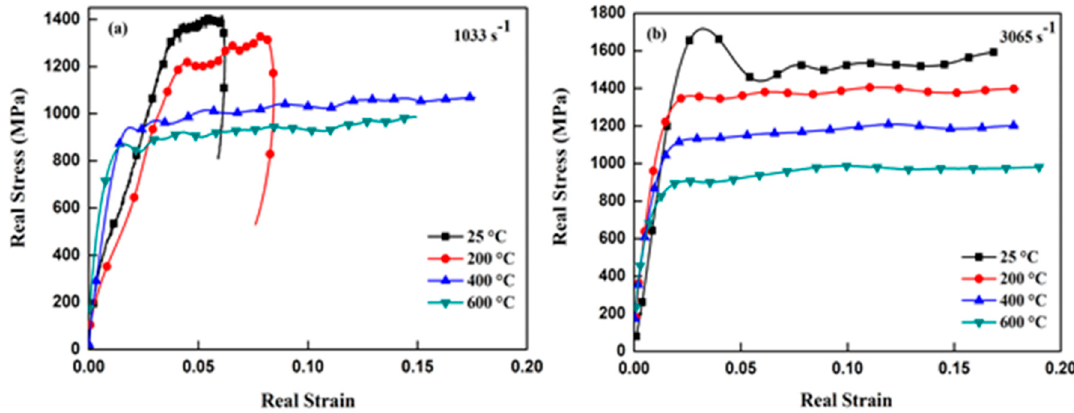
Figure 11. Stress–strain curve of TC18 alloy at the same strain rate and di ff erent temperatures (( a ) shows the stress–strain curves of di ff erent temperatures at • = 1033 s − 1 , ( b ) shows the stress–strain curves of different temperatures at • = 3065 s − 1 ).